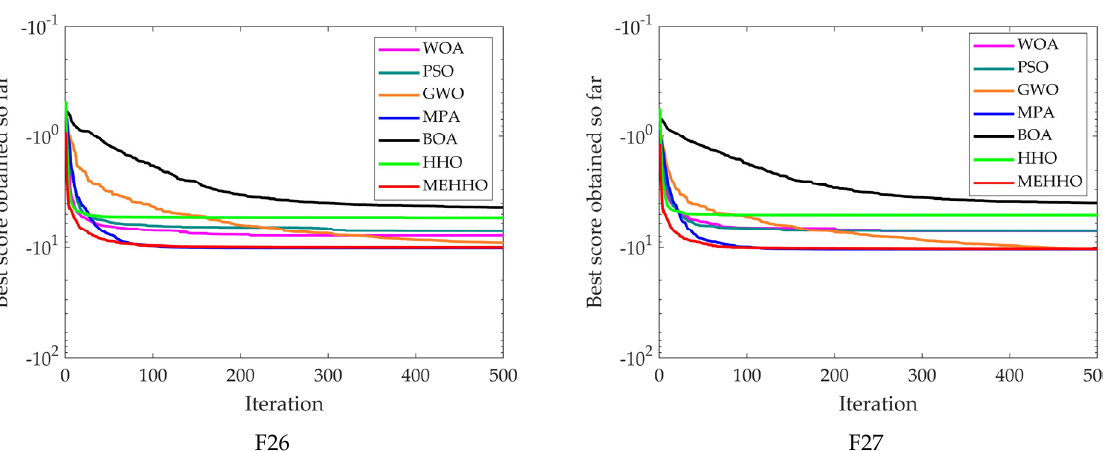
Figure 5. Convergence curve of partial fixed ‐ dimension multimodal functions (F26, F27).